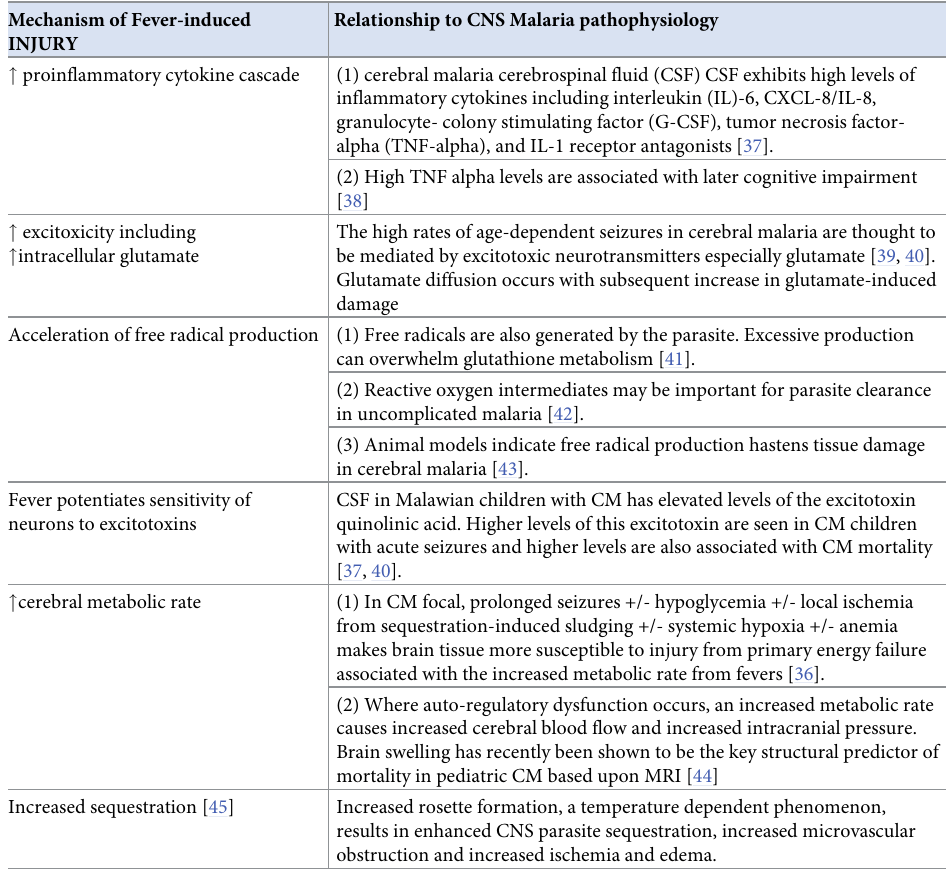
Table 2. Potential mechanisms of fever-induced brain injury in CNS